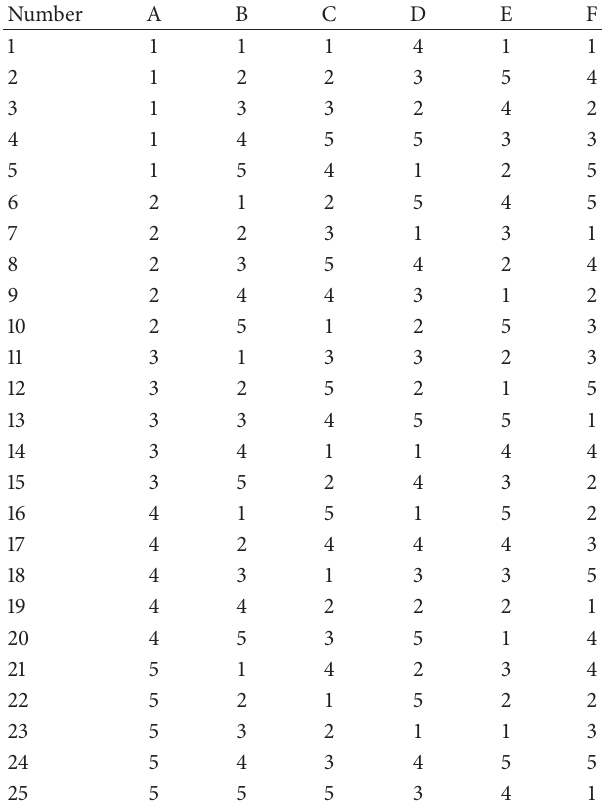
neurons in the hidden layer is 𝑝 ; ℎ𝑘 represent vector of the knowledge-based neurons values. The number of traditional hidden neurons is 𝑞(𝑝 + 𝑞 = 𝑚) ; ℎ represent output vector of traditional hidden neurons. Because no empirical formula is used here, there is no connection between input neurons and knowledge-based neurons. In short, the network combines the features of DC model and KBNN model; a part of the hidden neurons is used to generate the a priori knowledge and the other part is same as the traditional hidden neurons which are used to generate the difference between the coarse and fine models.